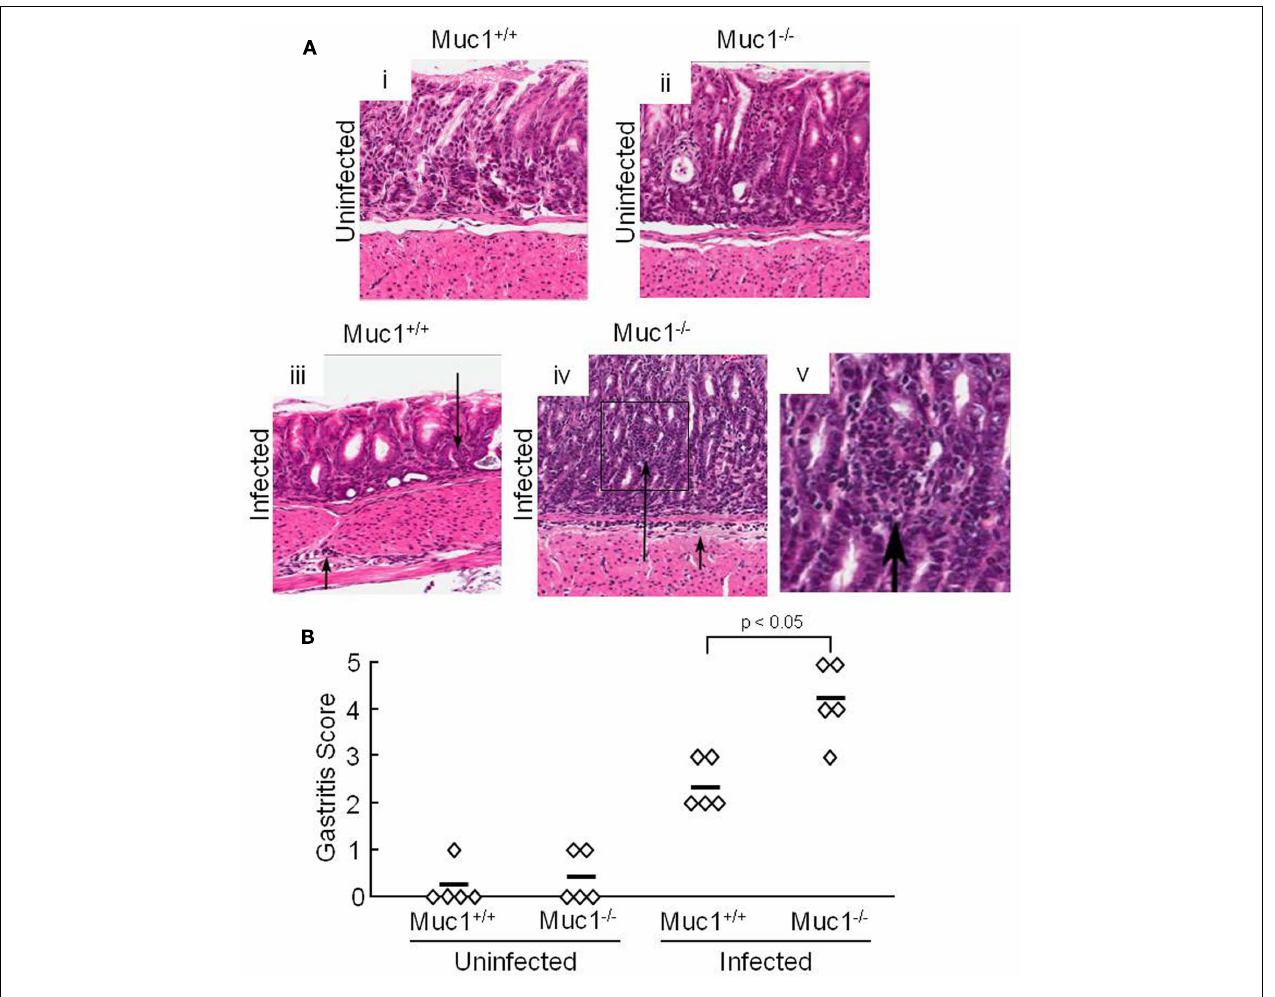
inflammation extending between glands and/or in submucosa; 3, patches of inflammation extending between glands toward the lumen and in the underlying submucosa; 4, intense transmucosal inflammatory infiltrate extending across the field distorting glandular architecture; 5, extensive mucosal and submucosal inflammation with disruption of glandular architecture and ulceration (Stuller et al., 2008). Each symbol represents an individual tissue section. Horizontal bars represent median values. Differences between median values were assessed by the Student’s t test. The results are representative of two